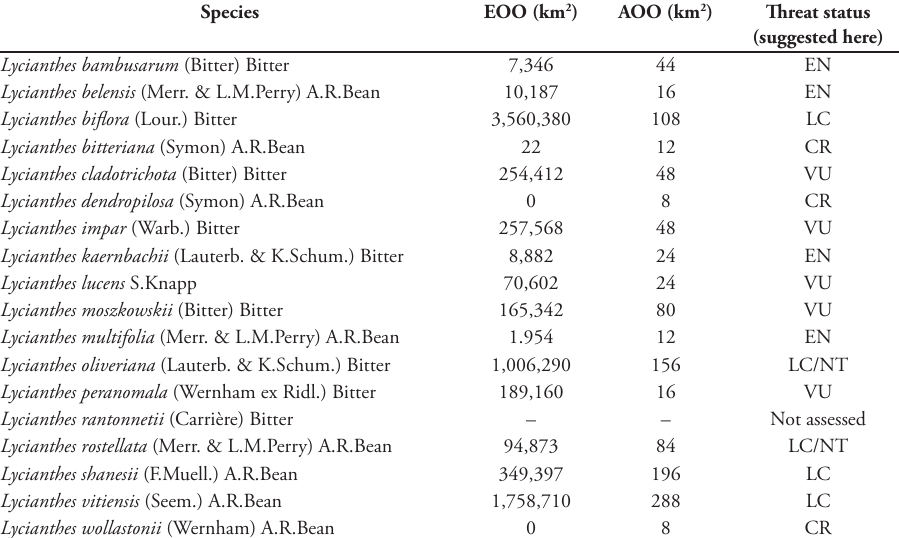
Table 3. Preliminary conservation assessments for the Lycianthes species of Australia, New Guinea and the Pacific. Abbreviations for threat status follow IUCN (2020). For discussion see individual spe- cies